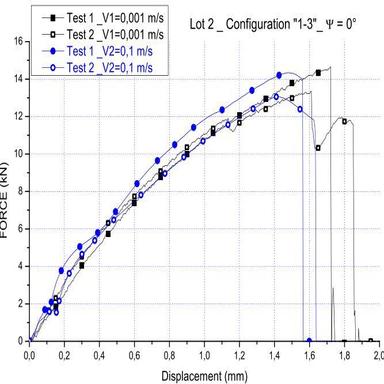
Loading velocity sensitivity under the pure opening load mode (ψ = 0∘ ).